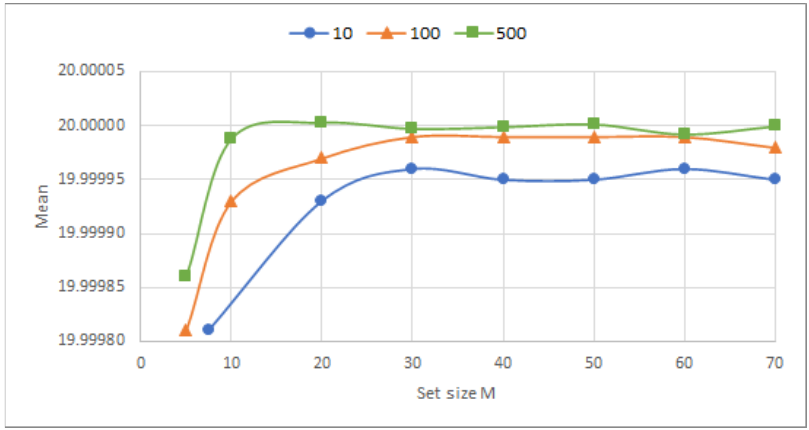
Figure 6. Response of several means ( N = 10, N = 100 e N = 500) with a variation of M (5, 10, 20, 30, 40, 50, 60 e 70). Table 1. Asymptotic Behavior with Increasing M .